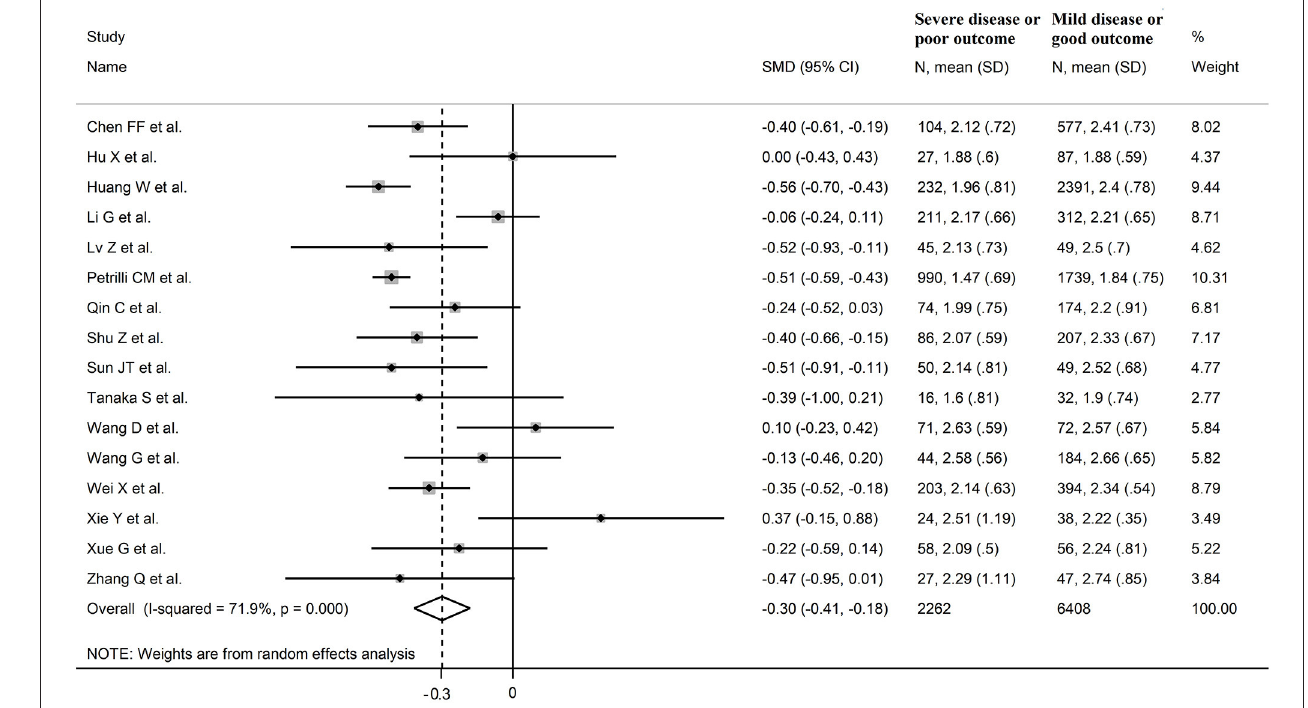
FIGURE 4 | Forest plot of studies examining LDL-cholesterol concentrations in